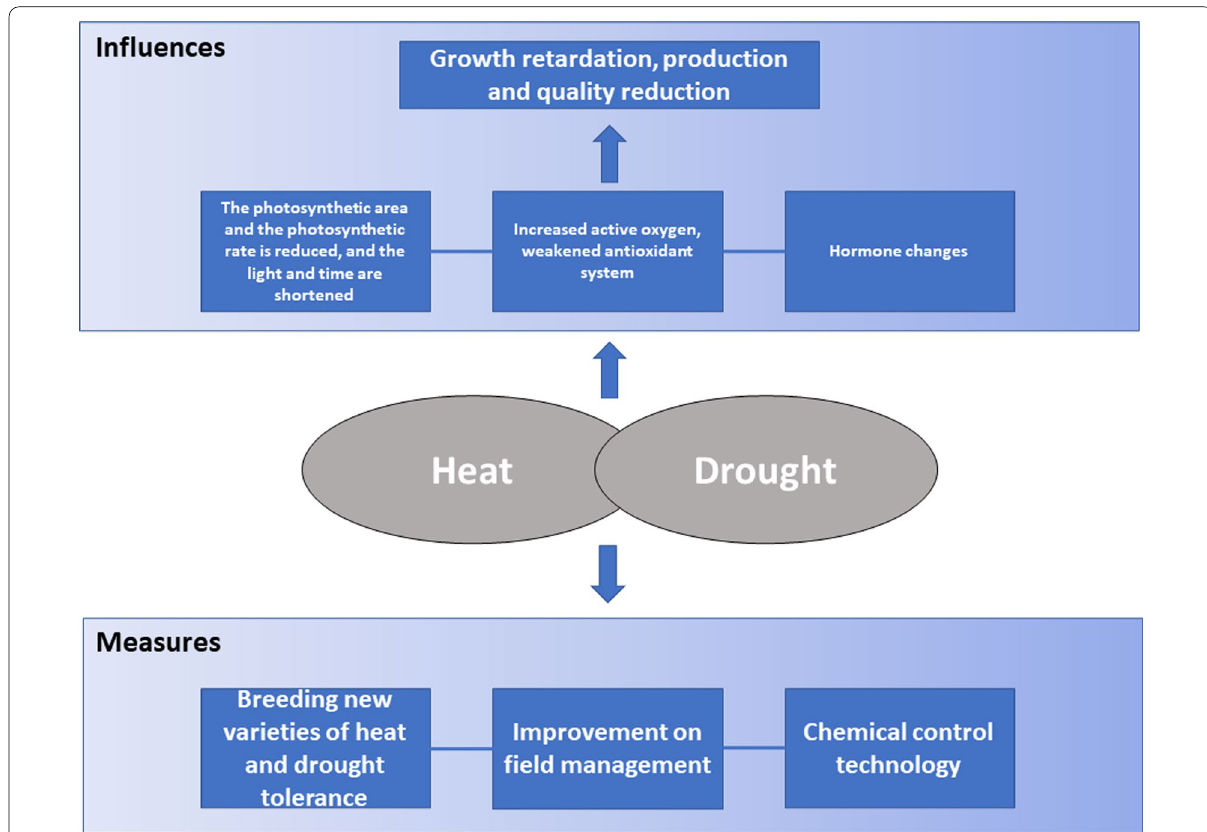
Fig. 2 A brief overview of the influences of heat and drought stress on rice and known